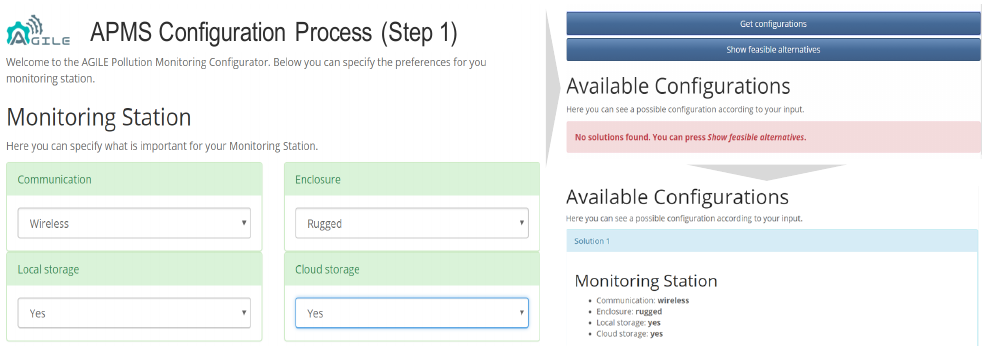
Figure 5. The APMS